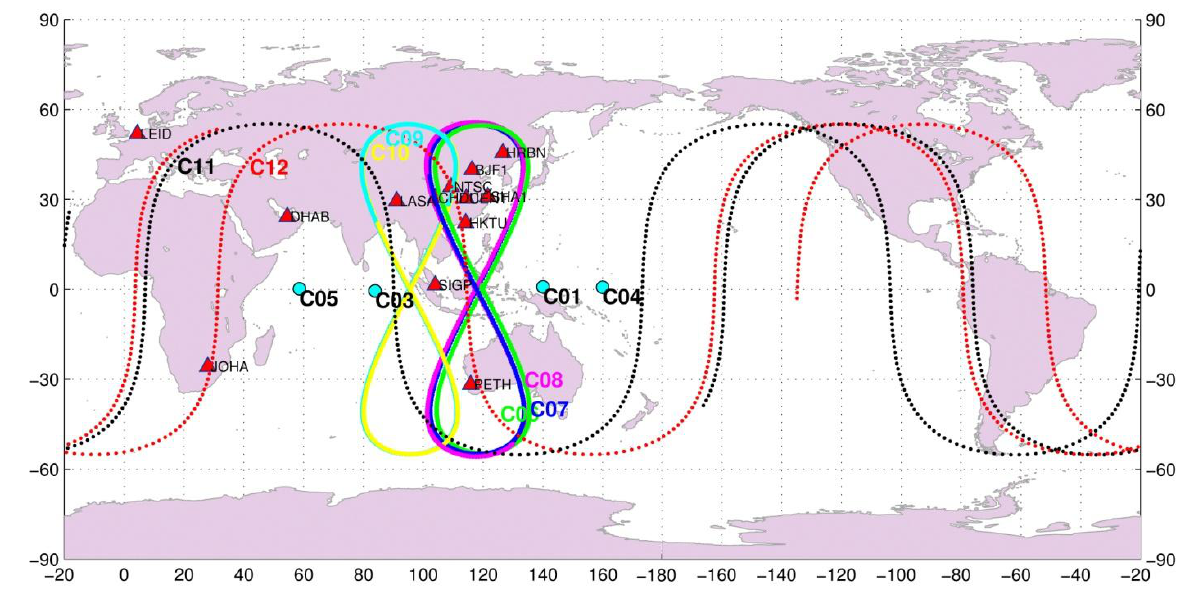
Figure 1. Ground tracks of the BeiDou satellites and distribution of the experimental tracking stations (for details see